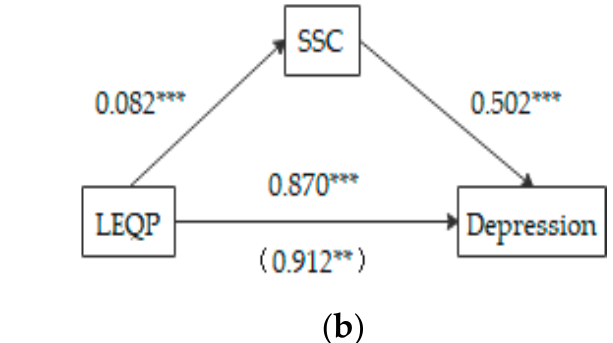
Figure 1. Mediation model of subjective social class. Total effect statistics in parentheses; * p < 0.05, ** p < 0.01, *** p < 0.001. ( a ) The mediating role of SSC between EQP and depression; ( b ) the mediating role of SSC between LEQP and depression.